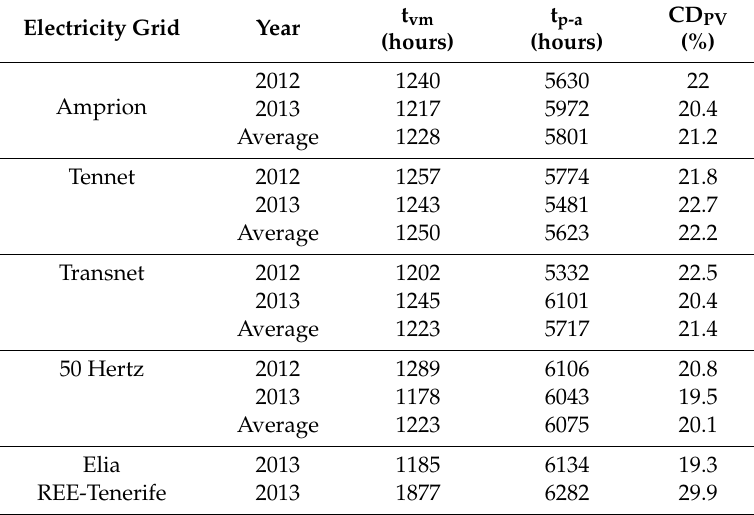
Table 2. CD PV estimation for several European large electricity